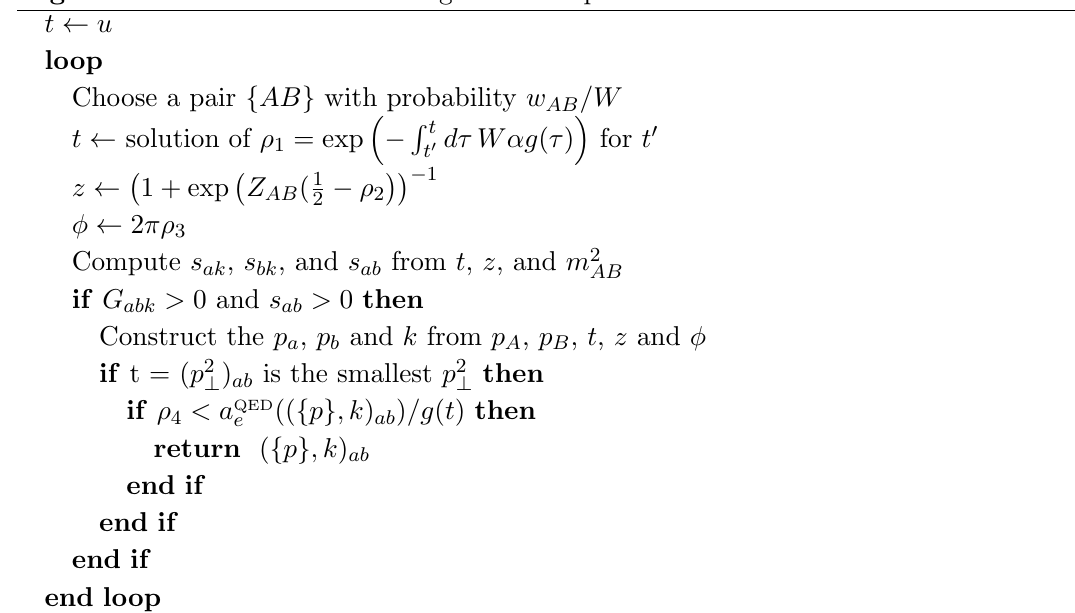
Algorithm 1 The Sudakov veto algorithm for photon